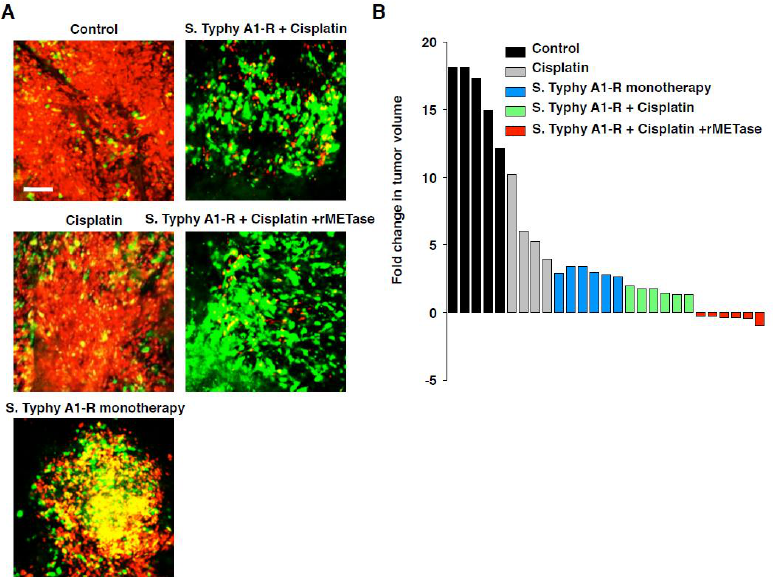
Figure 7. Decoy, trap, and shoot chemotherapy guided by FUCCI imaging. FUCCI-expressing MKN45 cells (5 × 10 6 cells/mouse) were injected subcutaneously into the left flank of nude mice. When the tumors reached approximately 8 mm in diameter (tumor volume, 300 mm 3 ), mice were administered S. typhimurium A1-R i.v. alone; or with CDDP (5 mg/kg i.p.) alone for 5 cycles every 7 days, or with a combination of S. typhimurium A1-R and CDDP; or with a combination of S. typhimurium